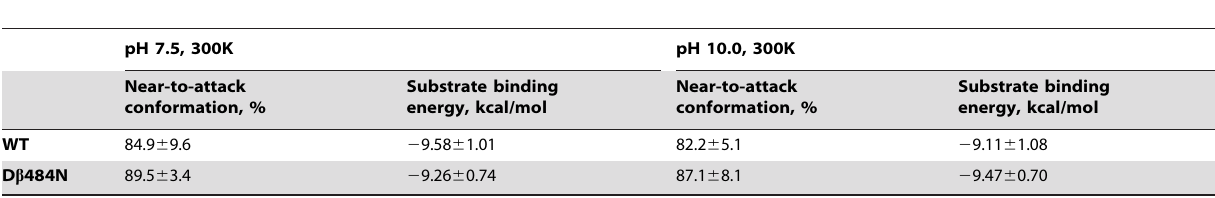
Table 3. In silico evaluation of catalytic activity of the wild type (WT) Ec PA and its D b 484N mutant.